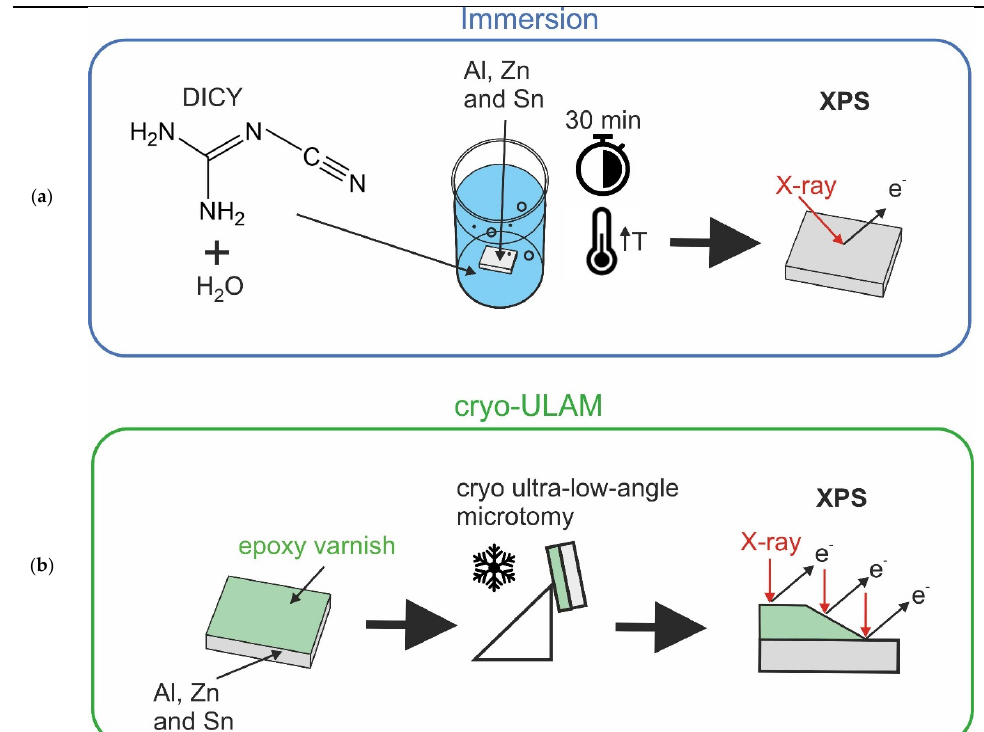
Figure 1. ( a ) Schematic representation of the immersion tests and ( b ) cryo-ULAM preparation fol- lowed by an XPS linescan.